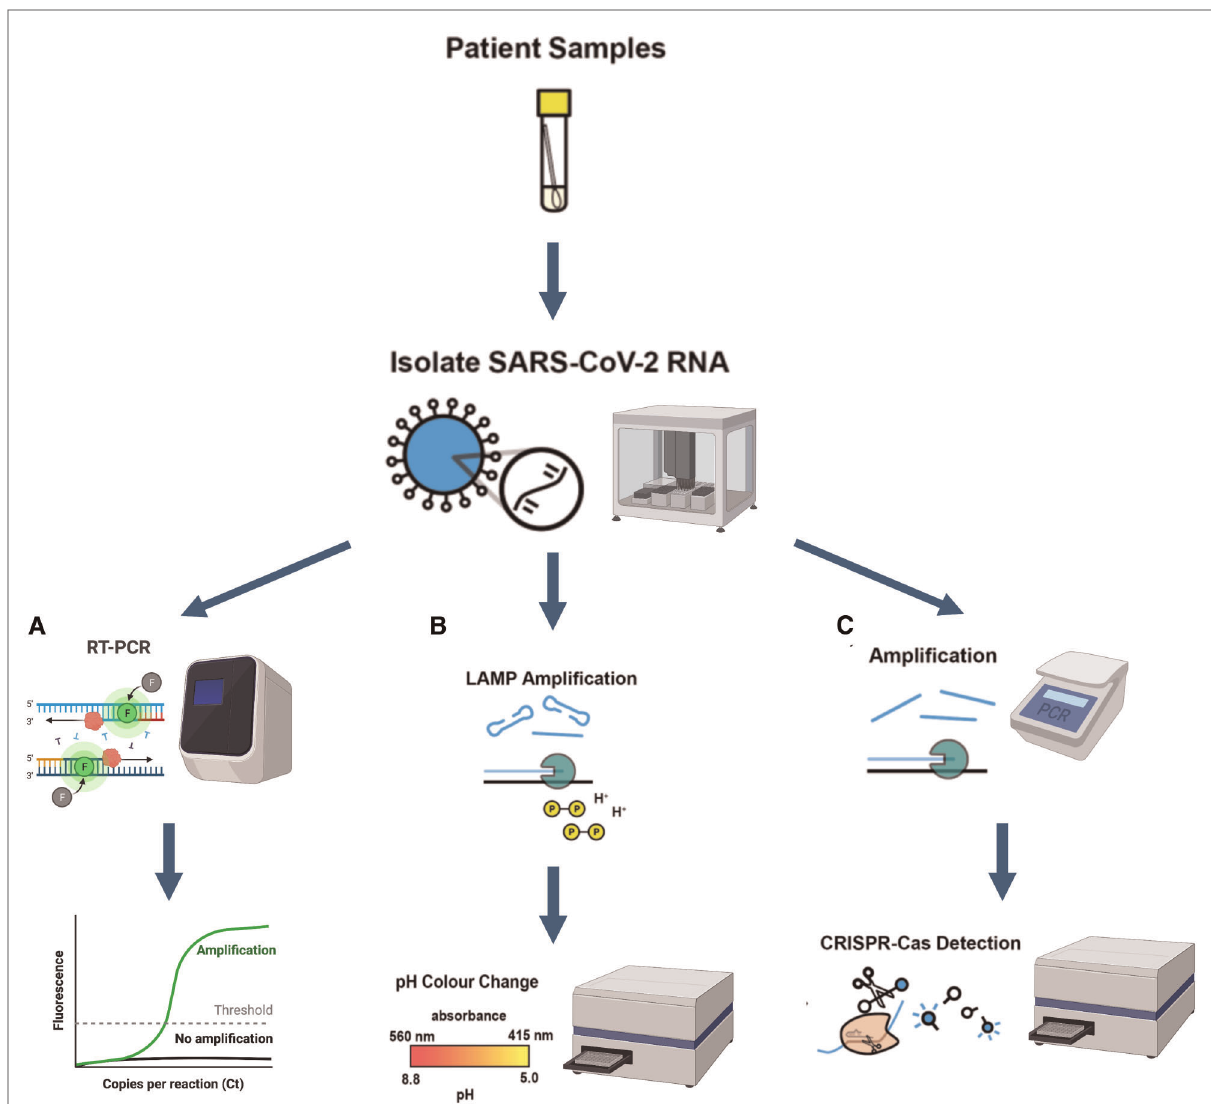
FIGURE 3 (created with BioRender.com). Schematic illustration of three different automated diagnostic work fl ows from patient samples and their corresponding required equipment ( A ) RT-PCR diagnostic work fl ow ( B ) LAMP diagnostic work fl ow ( C ) CRISPR-Cas13a nucleic acid detection work fl ow Equipment used for each work fl ow is also shown in the fi gure. A qPCR device is a necessity for RT-qPCR work while the plate